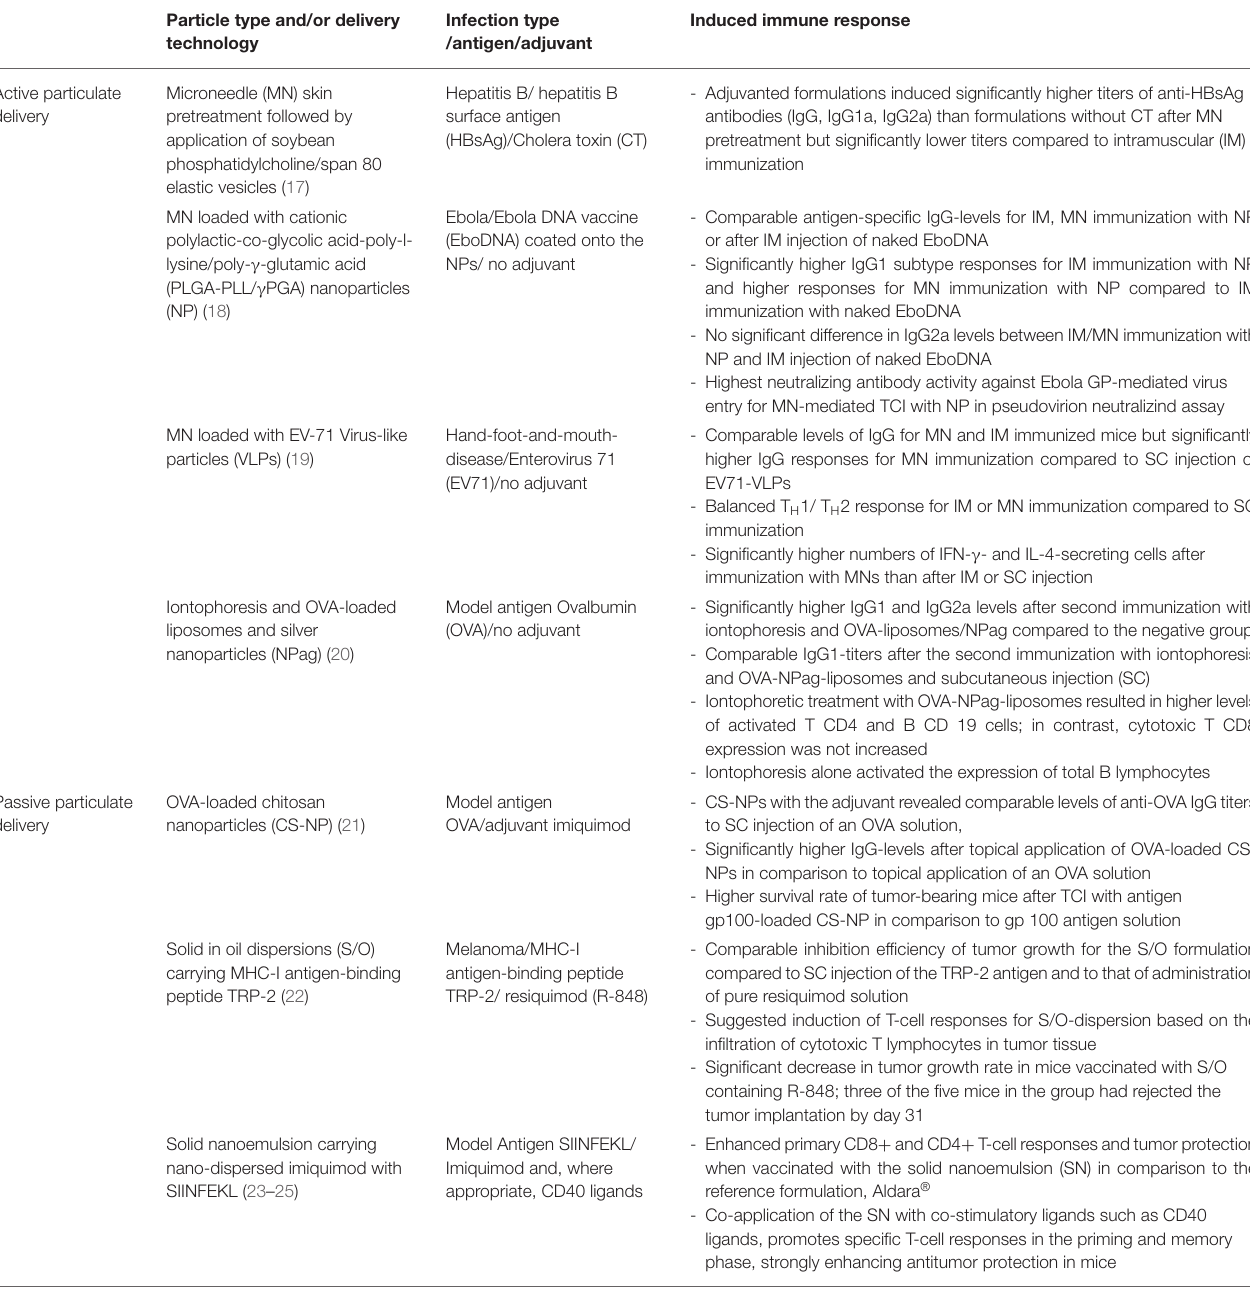
TABLE 1 | Overview of the particle type used, delivery technology, infection type, antigen and adjuvant used, and induced immune response in some of the presented